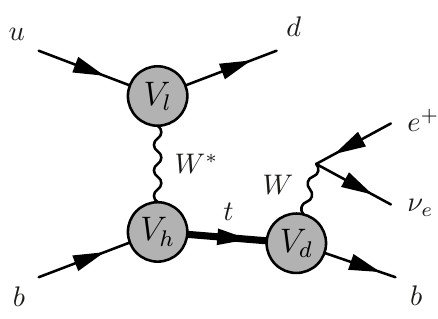
Figure 3 . Schematic diagram for t -channel single top-quark production at hadron colliders in the on-shell top quark approximation and the structure-function approximation. The full QCD corrections are factored into three di(cid:11)erent parts with these